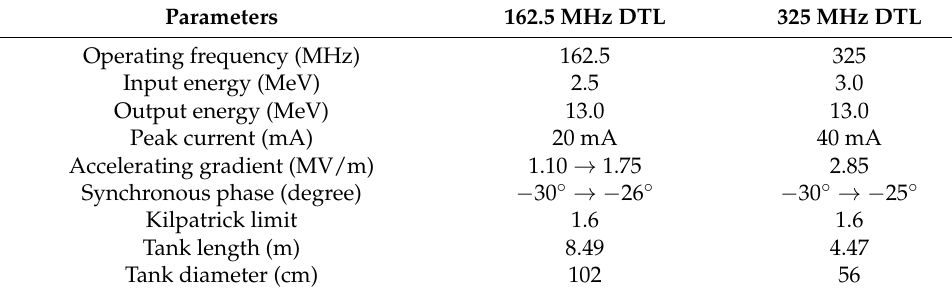
Table 3. General DTL parameters.